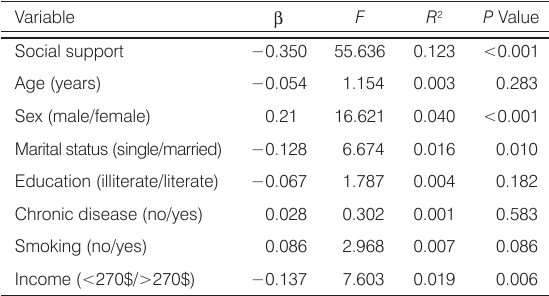
Table 5. Associations between SCL-90 total score and social support and demographic variables in univariate linear regression.